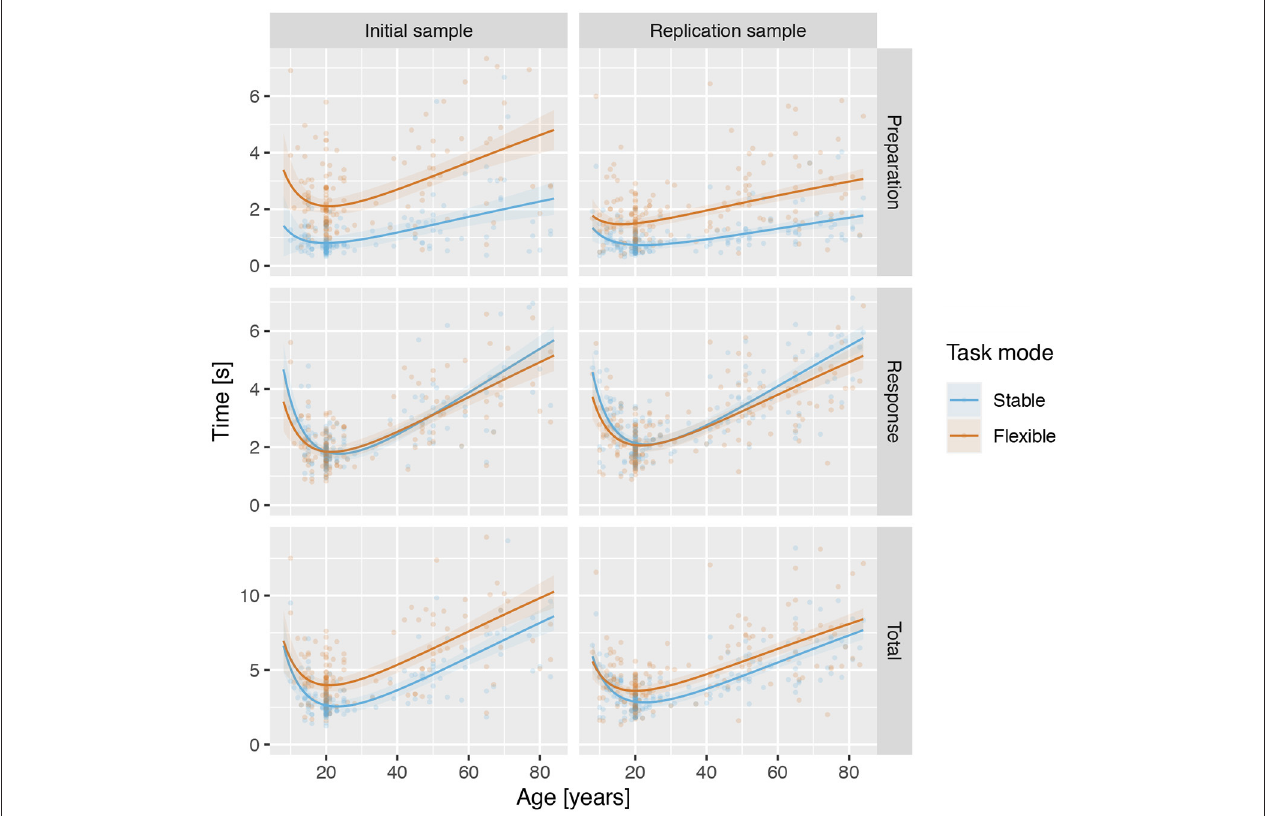
FIGURE 7 | Reaction times across lifespan for the stable and flexible task modes for both samples. Lines show predicted values based on robust linear regression, with age modelled as a second-degree polynomial of the logarithm of age in years, and shading shows the standard error of predicted